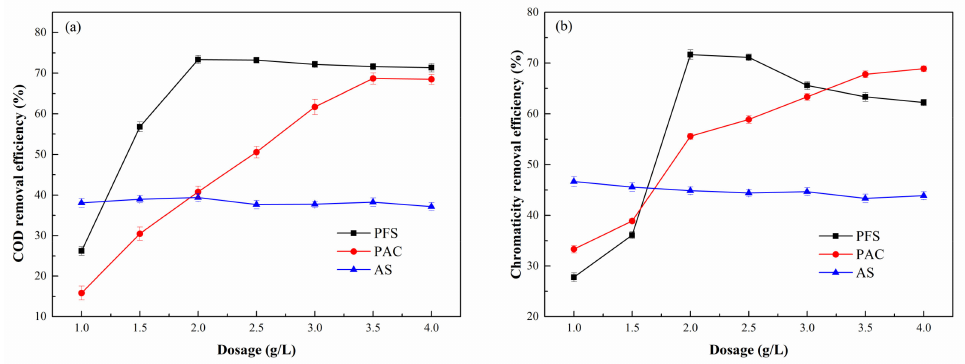
Figure 2. Effect of different coagulants and dosages on the removal efficiency of COD ( a ) and chromaticity ( b ).